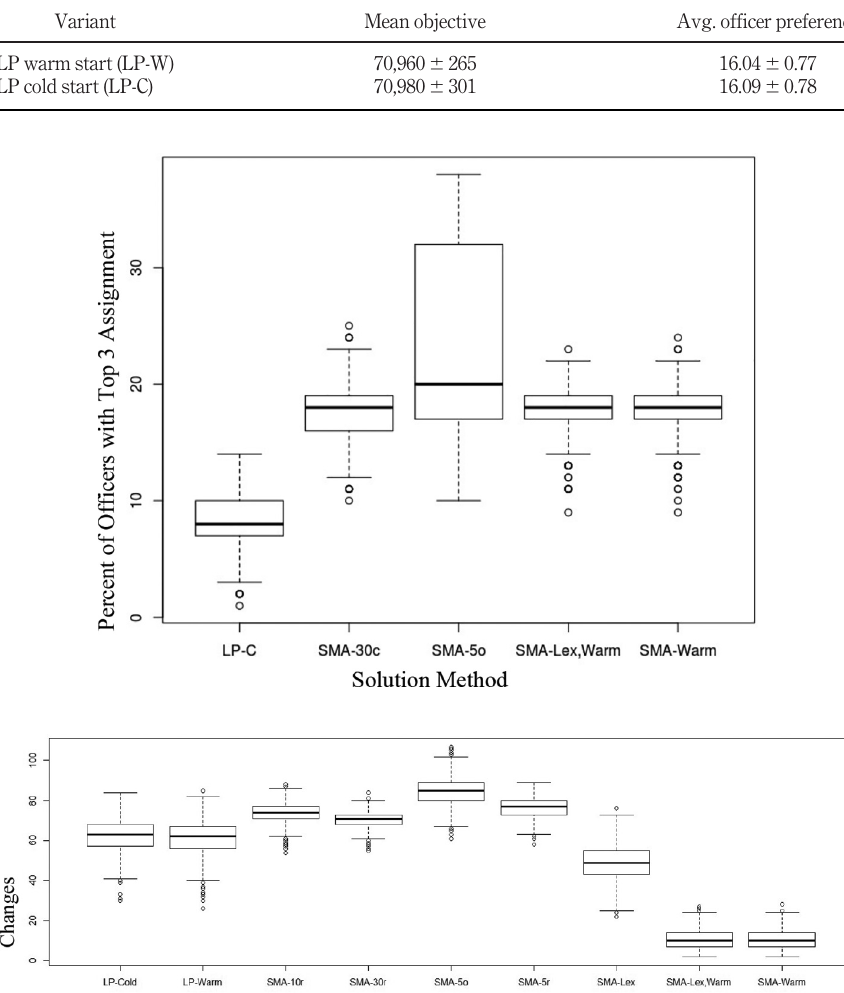
Figure 2. Robustness